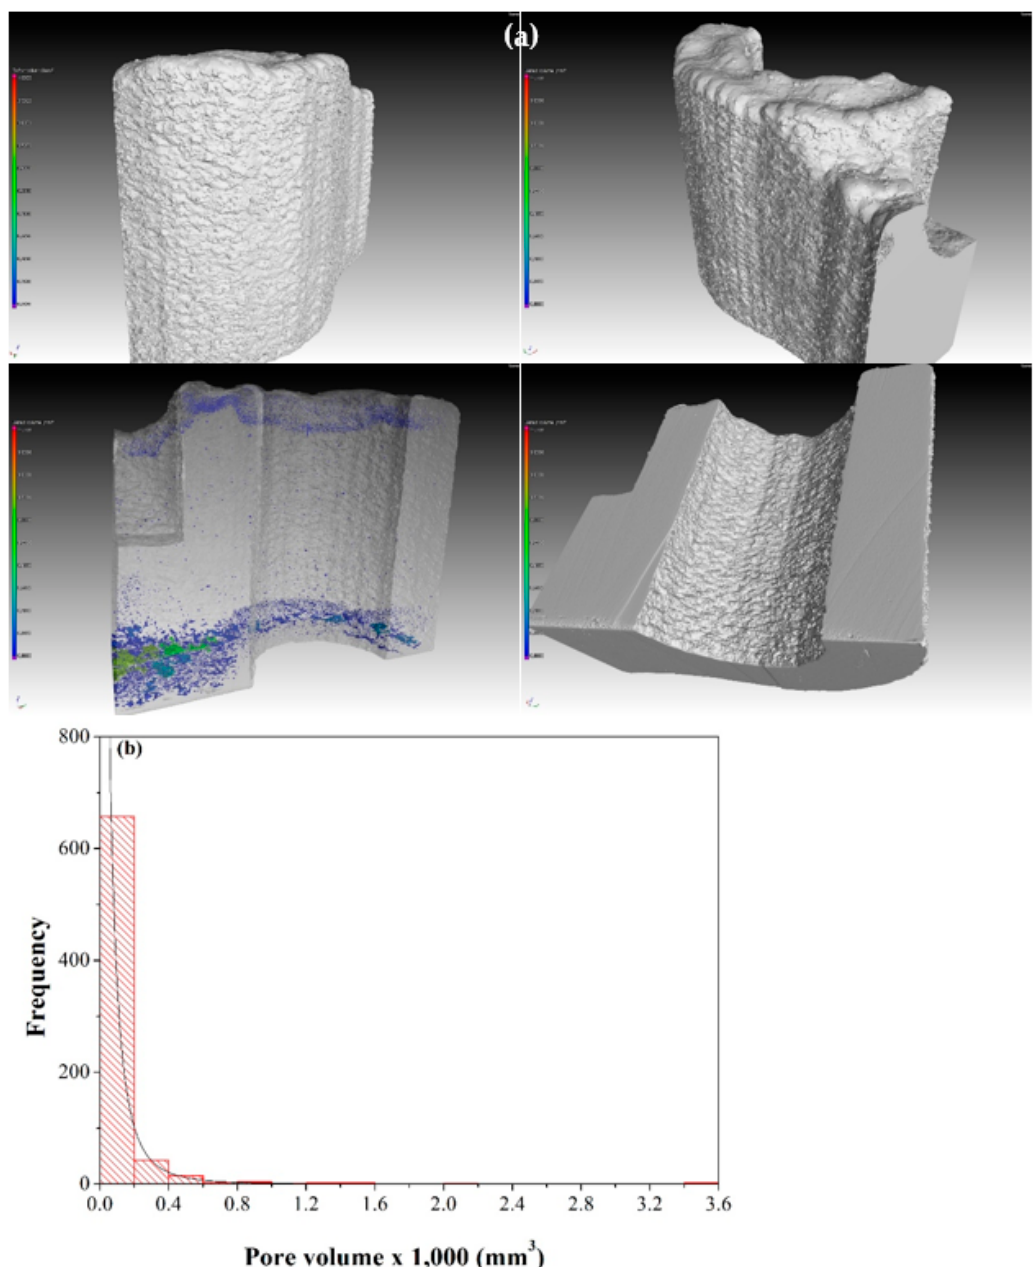
Figure 10. ( a ) A typical μ -CT scan of the cut Ti-6Al-4V fitting at 19.5 μ m voxel size from different angles. ( b ) Pore size distribution in pieces of the titanium fitting with lognormal distribution